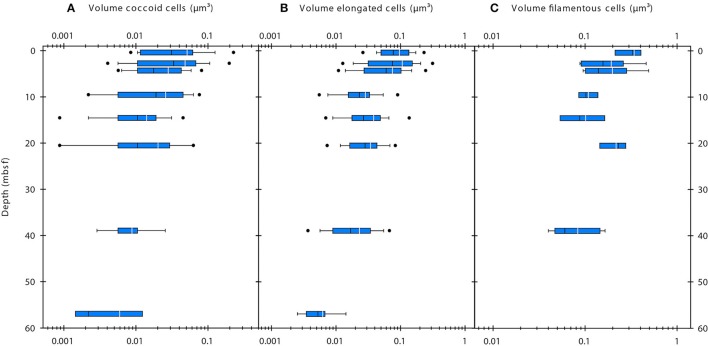
Volumes of coccoid (A), elongated (B), and filamentous cells (C) determined by epifluorescence microscopy. White line indicates mean value, black line indicates median value. The blue boxes indicate the 25th/75th percentile. Whiskers show 10th/90th percentile, dots show 5th/95th percentile.